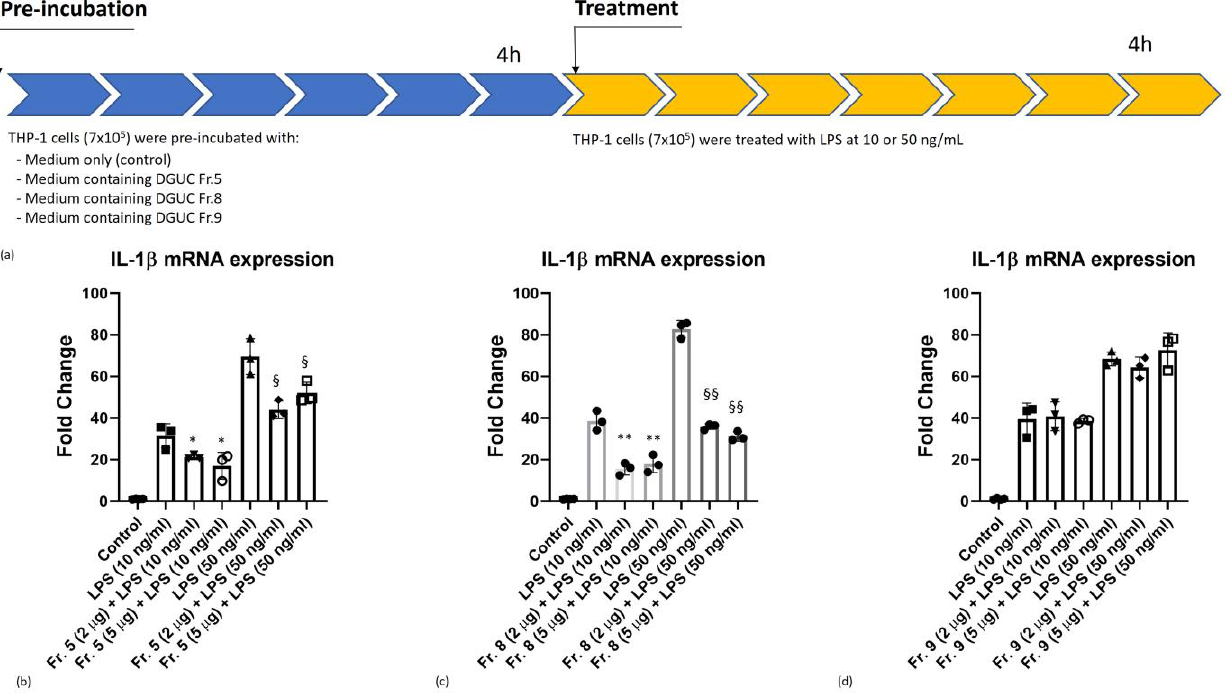
Figure 6. The anti-inflammatory activity of pristine tomato-derived nanovesicles (NVs) ( a ) pre-incubation and treatment conditions, ( b ) density gradient ultracentrifugation (DGUC) Fraction 5; ( c ) DGUC Fraction 8; and ( d ) DGUC Fraction 9 compared with controls. ANOVA test followed by Dunnett’s post hoc analysis. The level of significance was p ≤ 0.05 (*), p ≤ 0.01 (**) versus LPS (10 ng/mL) condition, and p ≤ 0.05 (§), p ≤ 0.01 (§§) versus LPS (50 ng/mL) condition.